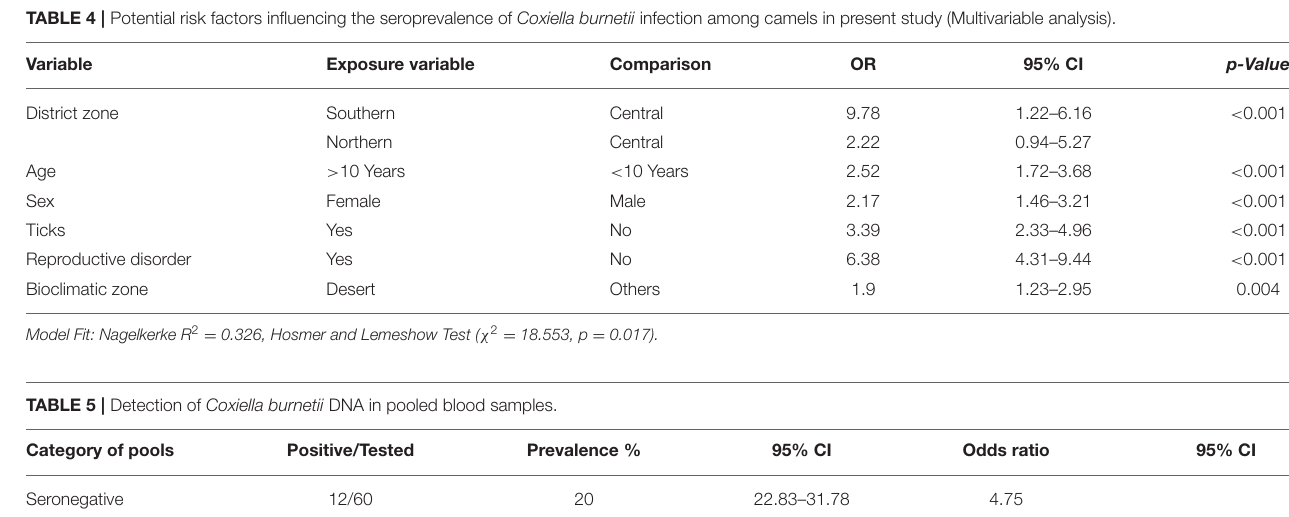
TABLE 4 | Potential risk factors influencing the seroprevalence of Coxiella burnetii infection among camels in present study (Multivariable analysis). Variable Exposure variable Comparison OR District zone